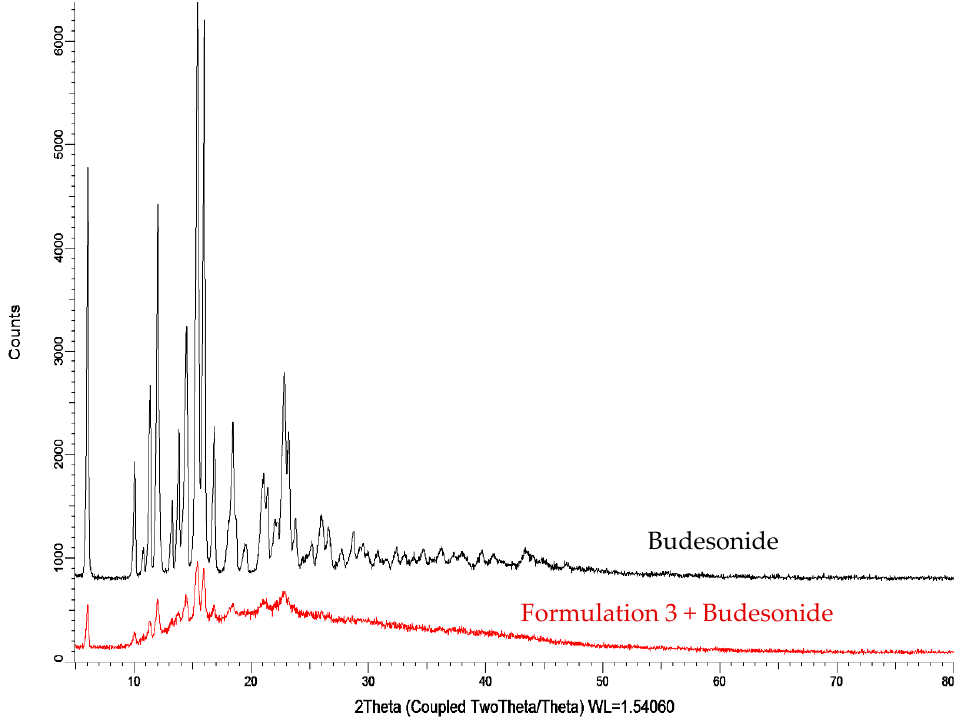
Figure 6. X-RD analysis budesonide and the loaded hydrogel.